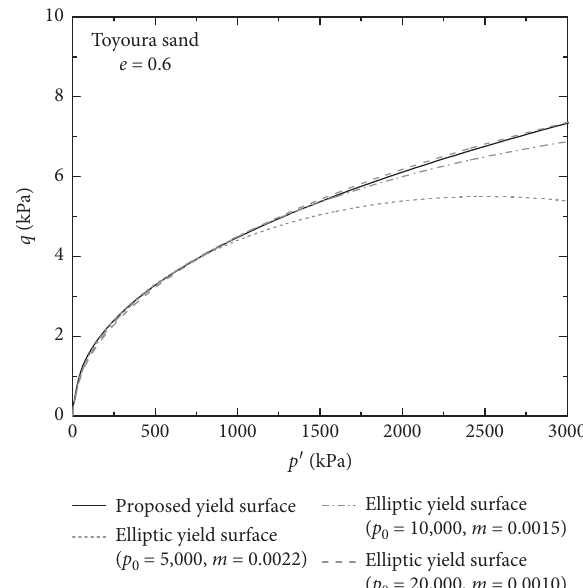
Figure 5: Determination of p 0 of the elliptic yield surface based on the proposed yield surface for Toyoura